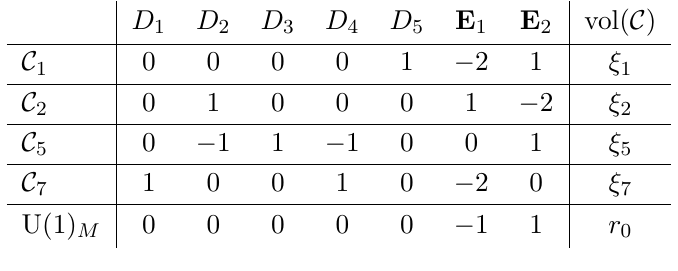
to hard walls along which the W-bosons W 2 and W 1 become massless, whereas the loci (cid:24) 2 + 2 (cid:24) 8 = 0 and (cid:24) 1 + 2 (cid:24) 8 = 0 are both not part of the K(cid:127)ahler chamber of f g f g